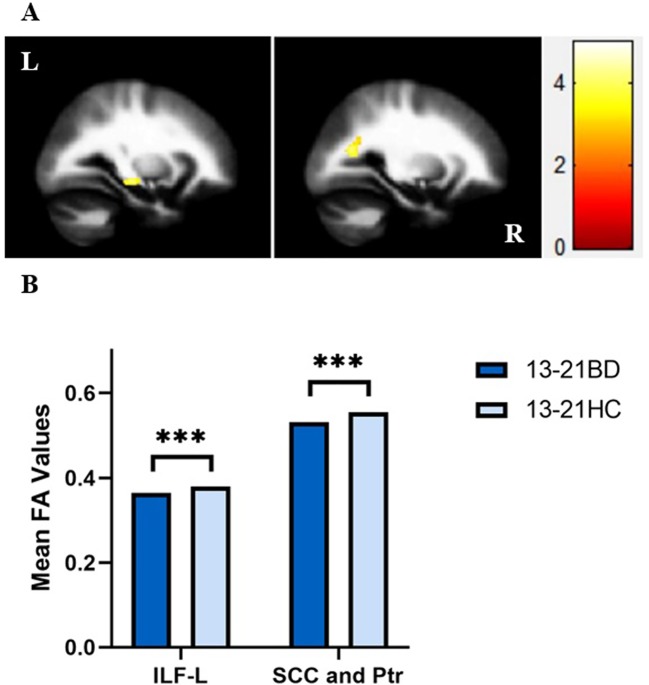
(A) Sagittal views showing significant differences in fractional anisotropy (FA) values in the left inferior longitudinal fasciculus (ILF), splenium of corpus callosum (SCC) and posterior thalamic radiation (Ptr) between bipolar disorder (BD) patients and healthy controls (HC) in the adolescent group from left to right as follows: (1) left ILF, and (2) SCC and Ptr [Montreal Neurological Institute (MNI) coordinates, respectively: x = -28 mm, y = -22 mm, z = -10 mm, 124 voxels, T = 4.11; x = -26 mm, y = -62 mm, z = 18 mm, 122 voxels, T = 4.25, p < 0.005 with Gaussian random field (GRF) correction]. (B) FA values in white matter fibers extracted from the left ILF, SCC and Ptr in BD patients and HC in the adolescent group. ***p < 0.001. ILF-L, left inferior longitudinal fasciculus; L, left brain; R, right brain. Color bars represent T values.